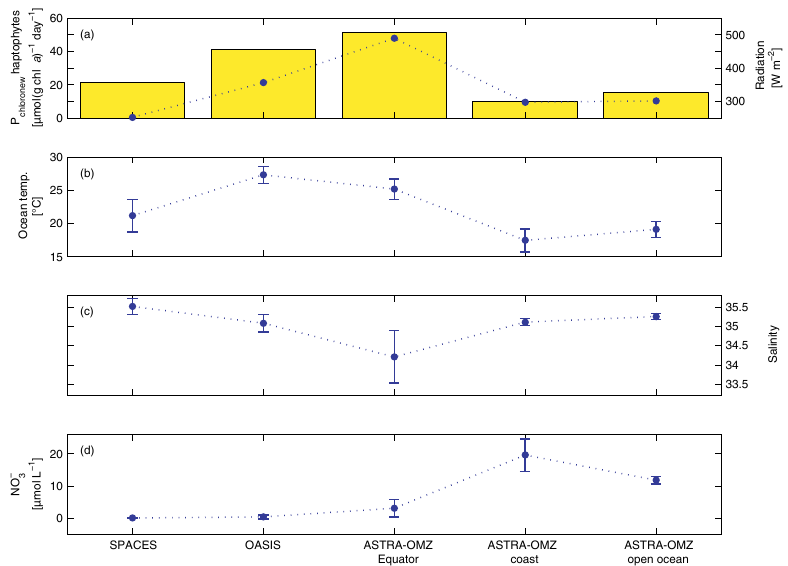
Figure 6. Mean values ( ± SD) for (a) calculated P chloronew haptophytes (blue line) and global radiation (yellow bars), (b) ocean temperature, (c) salinity, and (d) nitrate during SPACES, OASIS, and ASTRA-OMZ (split into three different parts: Equator, coast, and open ocean).